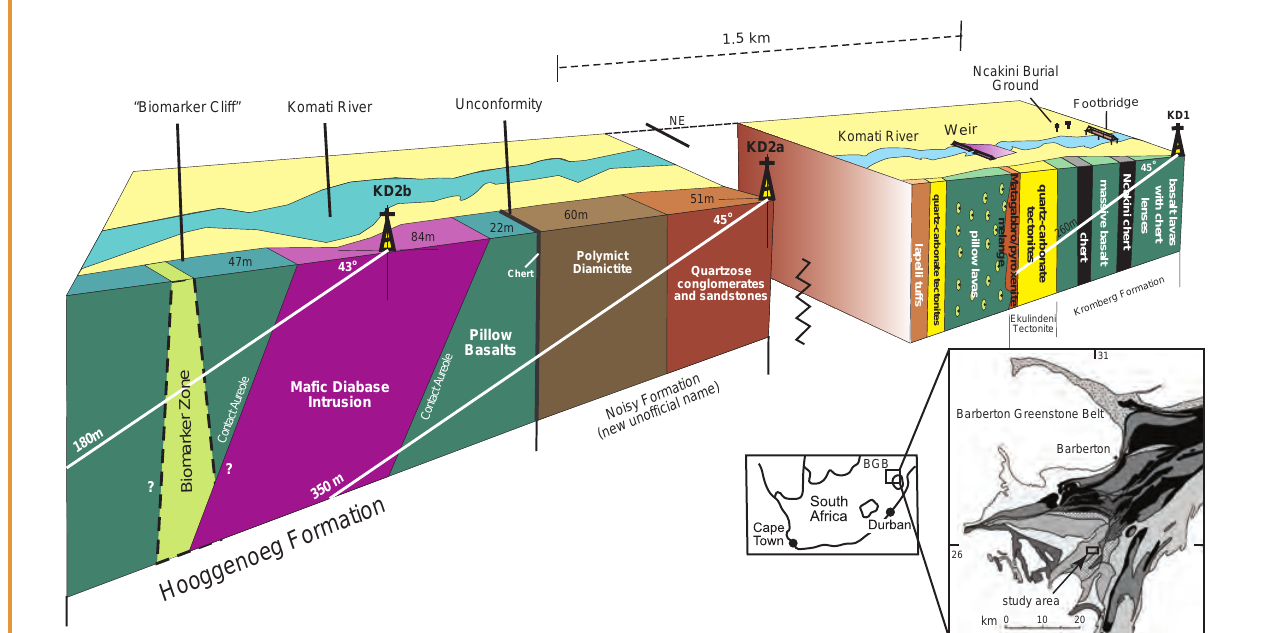
Figure 1. Three-dimensional block diagram with simplified geology depicting the positions and shallow drilling angles at drill sites KD1, KD2a, and KD2b and location maps of the study area with South Africa and simplified geology of Barberton Greenstone Belt (BGB map modified from Kareem,